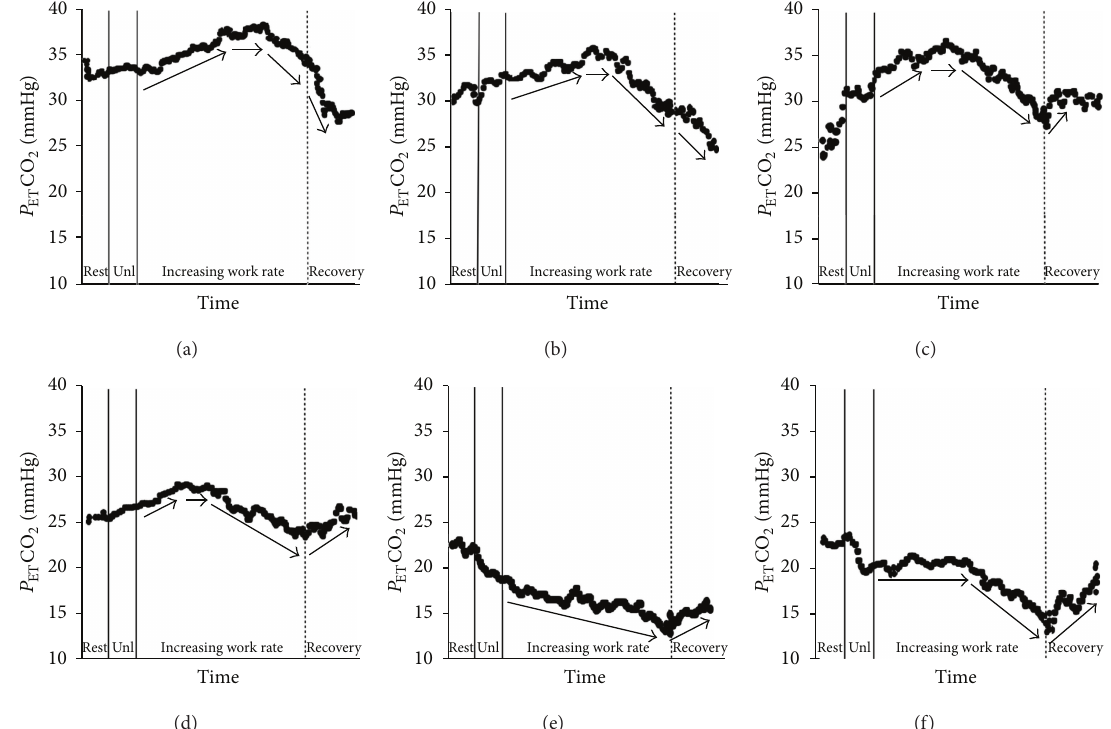
Figure 9: Time course of end-tidal partial pressure for carbon dioxide ( 𝑃 control( panel (a))andfivepatientswithpulmonaryarterialhypertensionofprogressingseverity( panels (b) to (f)).Notethat 𝑃 lower and even fails to increase as disease progresses. Moreover, it frequently increases (instead of diminishing) during recovery. Panel (f), in particular, depicts a severely impaired patient showing abrupt and sustained decrease in 𝑃 ovale (Figure 8). Unl is unloaded